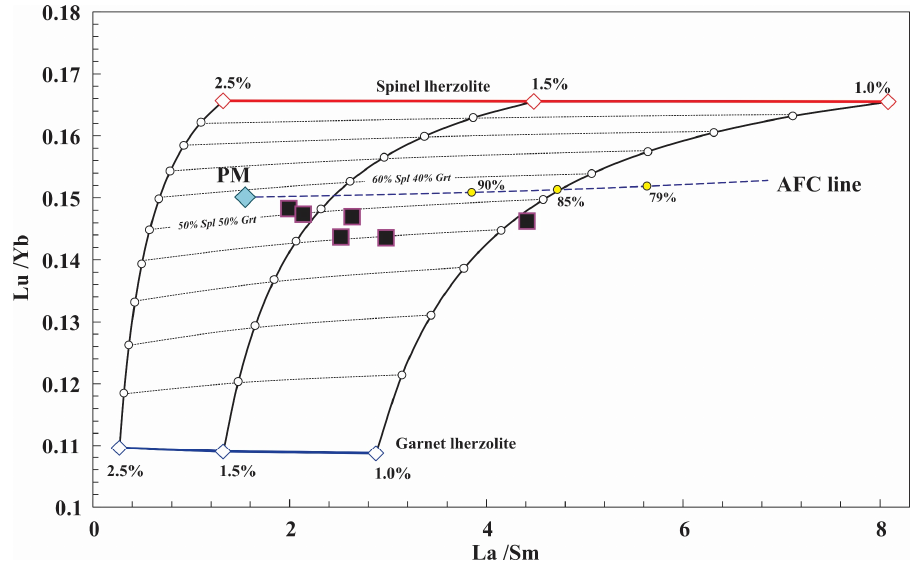
Figure 13. Assimilation and fractional crystallisation (AFC) model showing La/Sm vs. Lu/Yb bivariant diagram for gabbros. PM: Primitive Mantle.